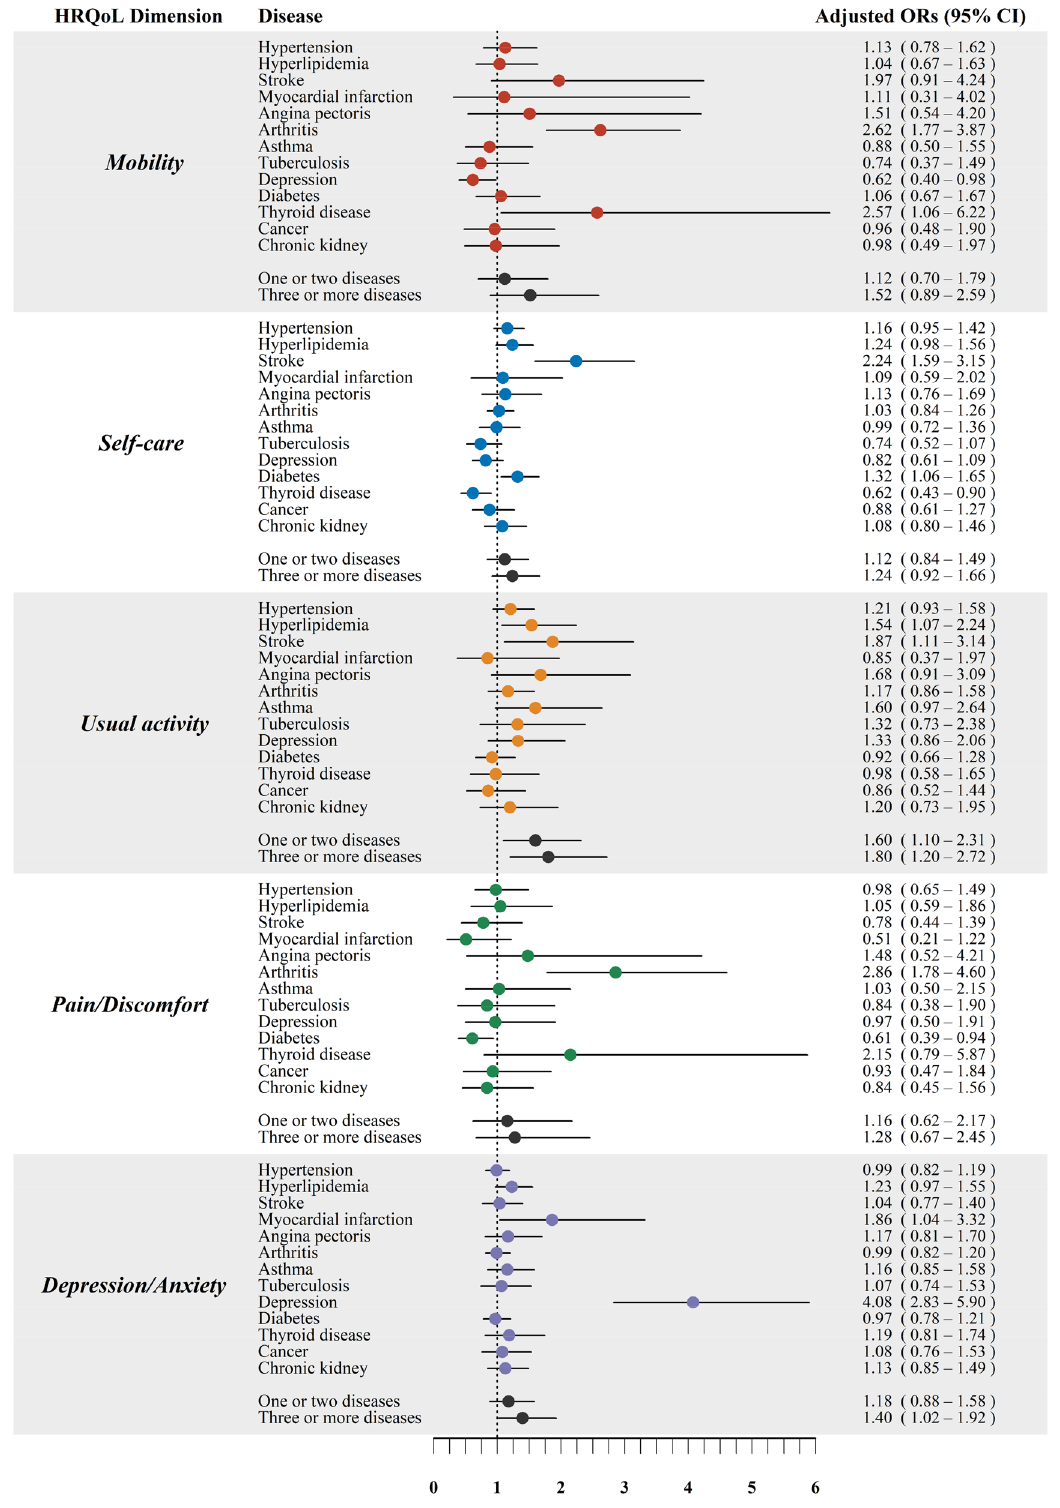
Figure 2. Multivariate logistic regression analysis of reporting problems in five HRQoL dimensions by different morbidities. Models were fitted separately for each HRQoL dimension and adjusted for age, gender, income level, and education level. The outcome variable in the logistic regression model was defined as "reporting no problem" versus "reporting problem" (either moderate or extreme